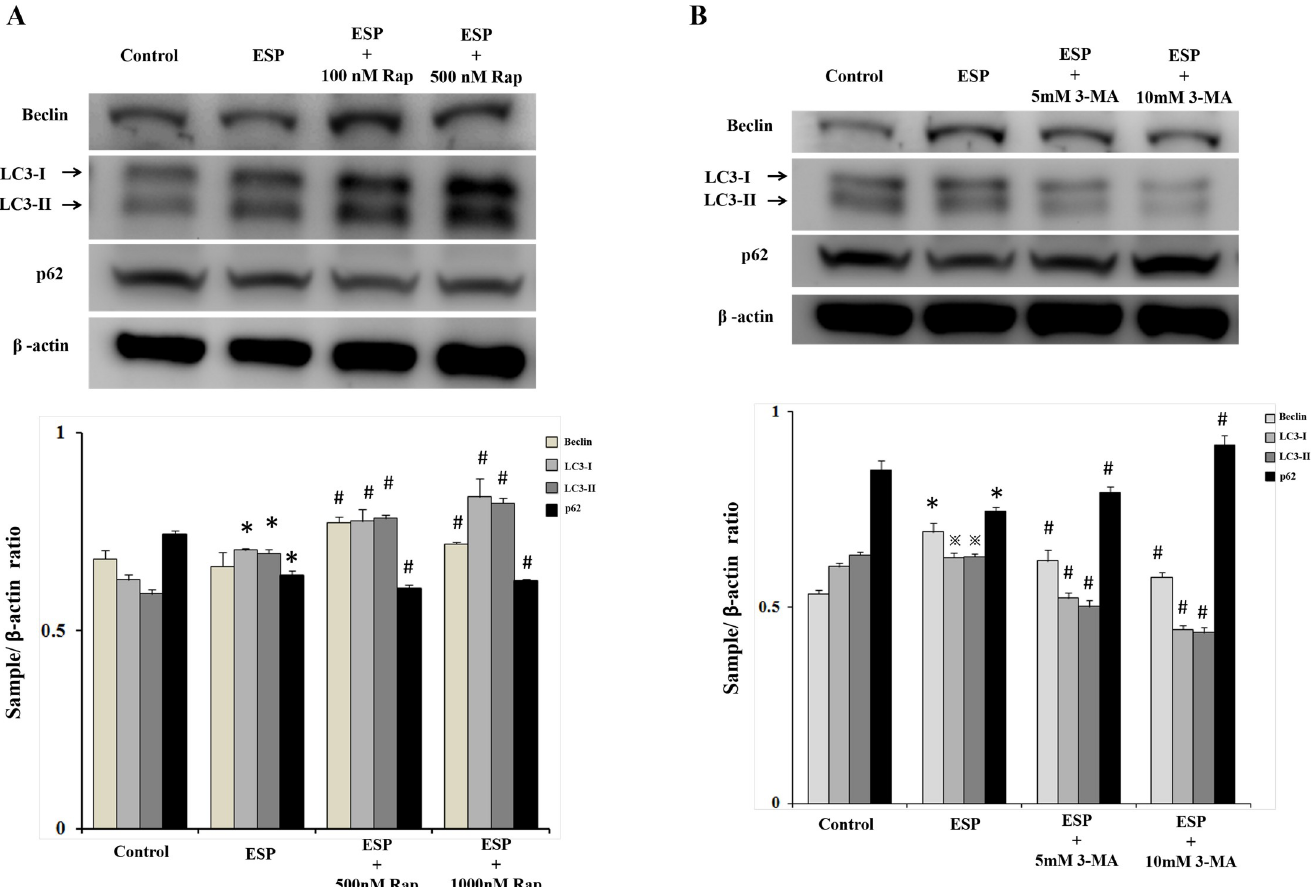
Fig 4. Rapamycin induces autophagy in excretory/secretory product-treated astrocytes. (A) Cells were pretreated with 100 or 500 nM rapamycin for 1 h and then incubated with 500 μ g/ml A . cantonensis L5 excretory/secretory products (ESPs) for 12 h. Western blotting was used to analyze the expression levels of the autophagy- related proteins LC3-I, LC3-II, Beclin, and p62. β -actin is shown as the control. (B) Cells were pretreated with 5 or 10 mM 3-methyladenine (3-MA) for 1 h and then incubated with 500 μ g/ml A . cantonensis L5 excretory/secretory products (ESPs) for 12 h. Western blotting was used to analyze the expression levels of the autophagy- related proteins LC3-I, LC3-II, Beclin, and p62. β -actin is shown as the control. The data are expressed as the means ± SD from three independent experiments ( n = 3). ※ P < 0.05, � P < 0.01, compared with the respective values of the control. # P < 0.01, compared with the cells exposed to ESPs.